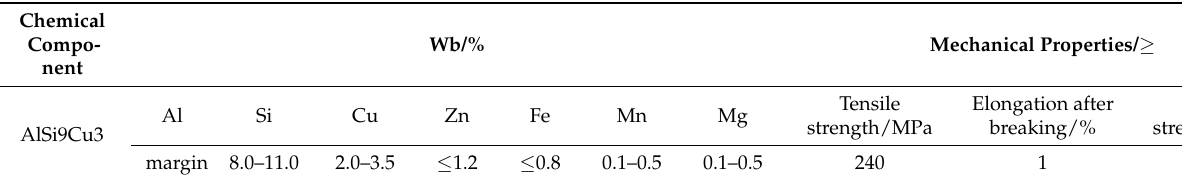
Figure 1. Gearbox structure diagram. ( a ) Bottom view of gearbox, ( b ) Top view of gearbox. Table 1. Material Composition and Mechanical Properties.